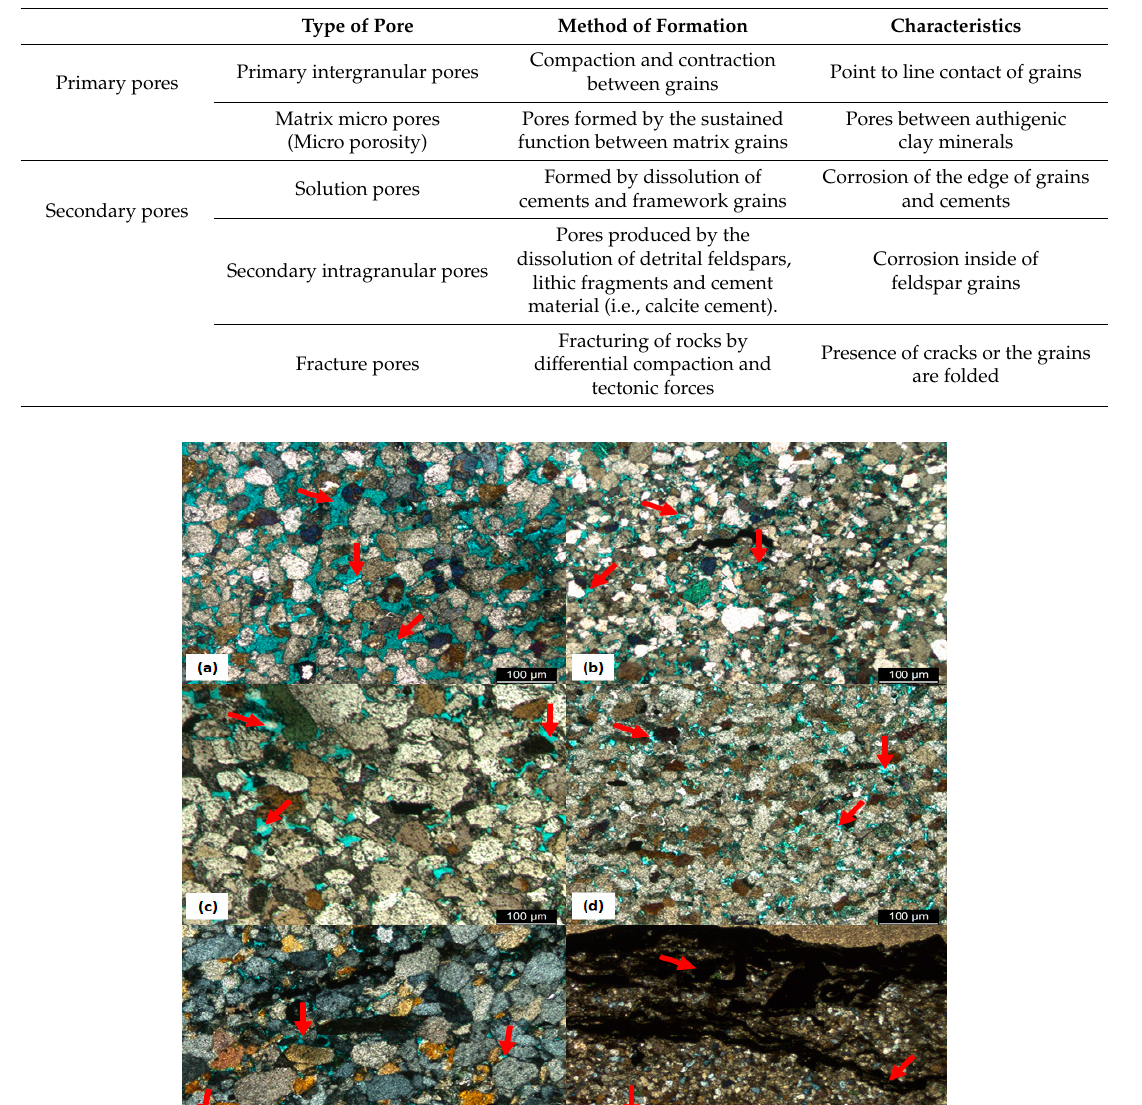
Table 7. Observed pores in the sandstones of the Bredasdorp Basin.